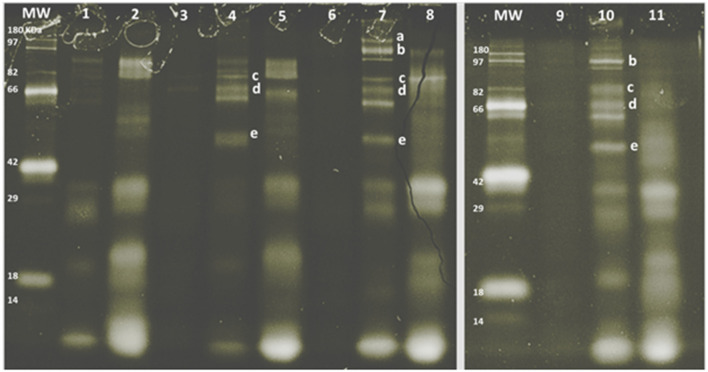
SDS-PAGE pattern of milk fat globule membrane (MFGM) glycoproteins in milk and MFGM purified before and after digestion. MW, molecular weight marker. The MFGM proteins are from phospholipid concentrate (lane 1), digested phospholipid concentrate (lane 2), bovine milk (lane 3), bovine MFGM (lane 4), digested bovine MFGM (lane 5), caprine milk (lane 6), caprine MFGM (lane 7), digested caprine MFGM (lane 8), ovine milk (lane 9), ovine MFGM (lane 10), and digested ovine MFGM (line 11). Proteins were identified accordingly with MW as (a) xanthine oxidase (~145 kDa), (b) PAS III (~100 kDa), (c) CD36 (~75 kDa), (d) butyrophilin (64 kDa bovine, 67 kDa caprine), (e) lactadherin (PAS 6/7; 52–58 kDa bovine, 55 kDa caprine).